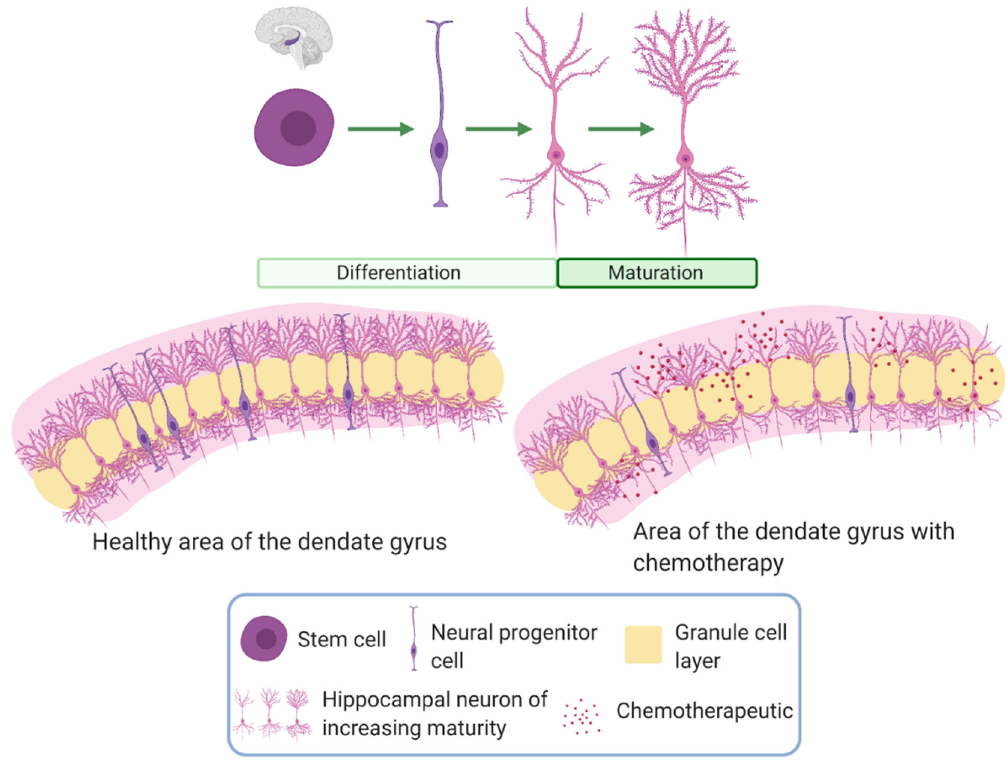
Figure 2. Neurogenesis and neural maturation with chemotherapy. The top image shows the progression of neurons from the stem cell to neural progenitor cell into neurons, which then mature, designated by the increase in processes and spines. The image below shows differences in neurogenesis observed in the dentate gyrus with chemotherapy. Chemotherapy results in a decrease in proliferative processes including neurogenesis and progenitor proliferations. This effect is seen through a reduction in neural progenitor cells and impaired maturation of neurons. Neurogenesis and neural maturation are reduced in APOE4 individuals compared to those carrying the APOE3 genotype. Stem cells from APOE4 individuals produce fewer neural progenitor cells compared to APOE3 individuals. Impaired neuron differentiation leads to slower maturation of neurons in APOE4 individuals, resulting in less complex neurons.